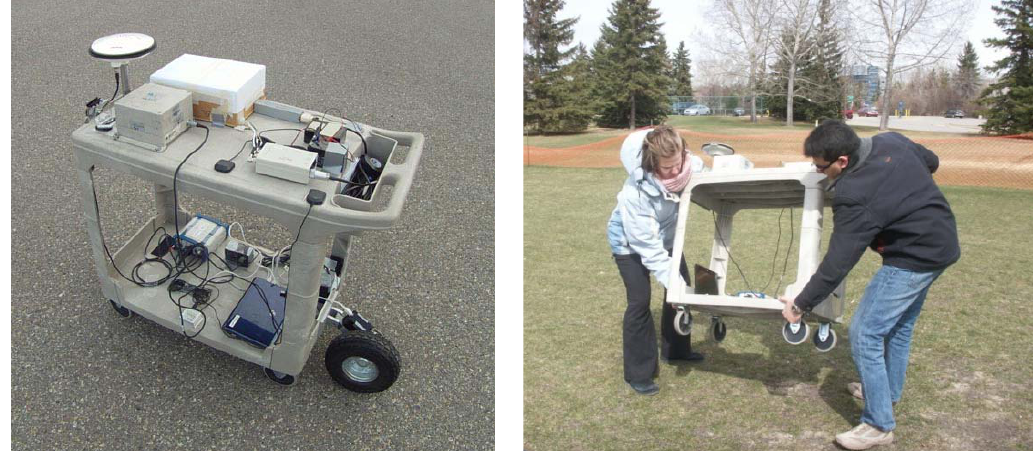
Figure 4. Probability Density Function (PDF) of total field gradient during constant field